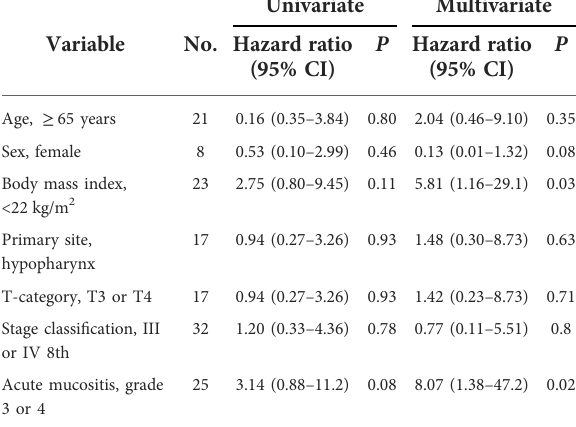
TABLE 3 Univariate and multivariate analyses of dysphagia; FOIS level V or